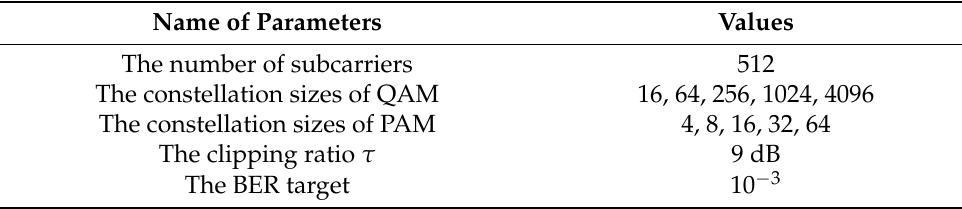
Table 2. System specifications.